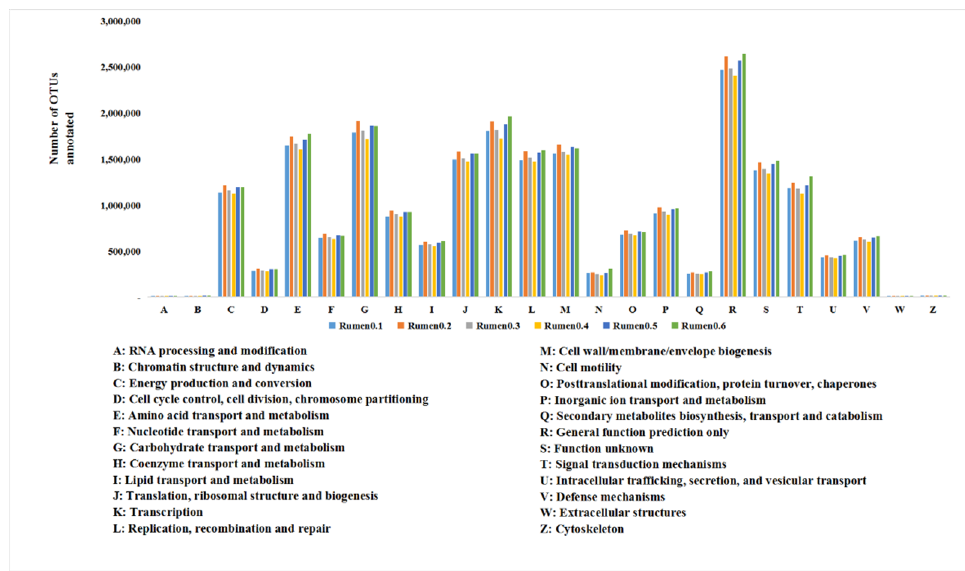
Figure 3. Prediction of Cluster of Orthologous Groups of proteins (COG) function of rumen flora.